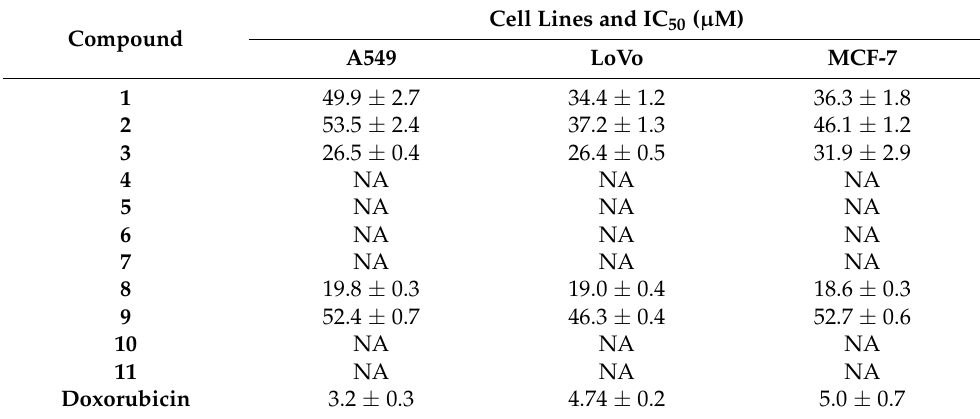
Table 2. Cytotoxic effects of isolated compounds against three cancer cell lines 1 .